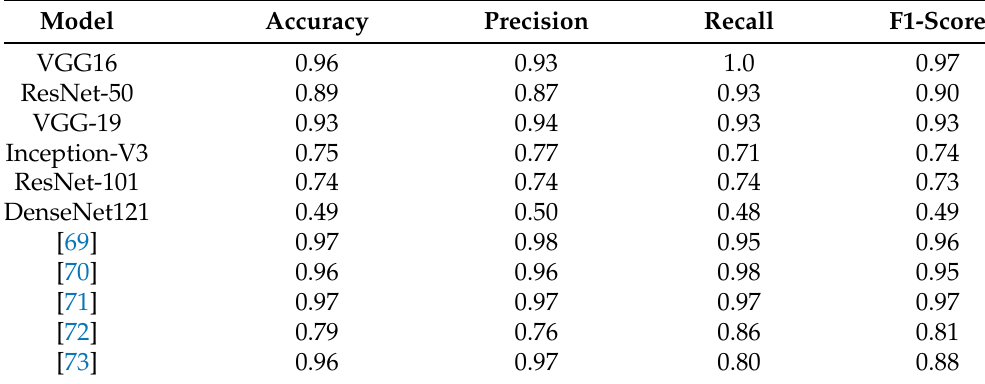
Table 4. Comparison table between different